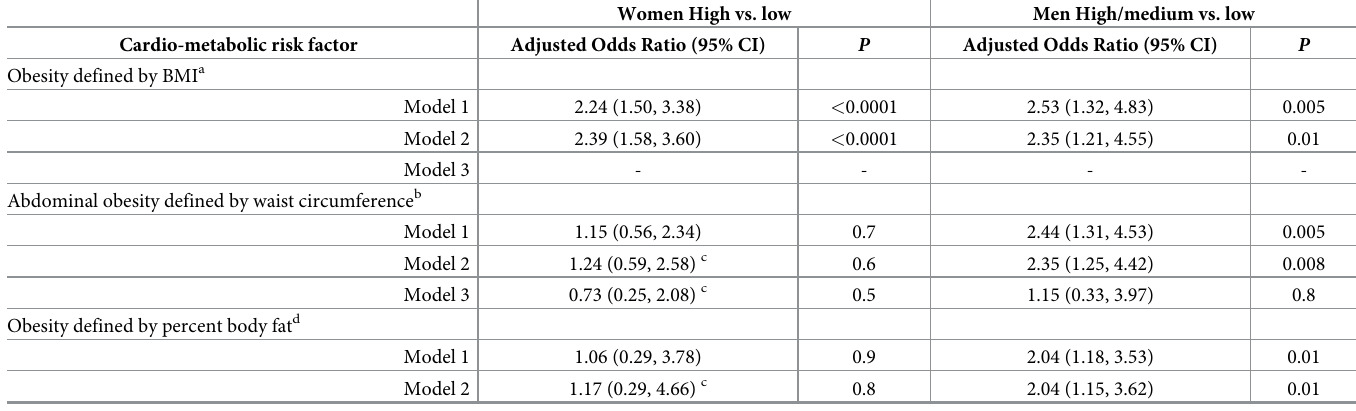
Table 2. Multivariable logistic regression models to predict cardio-metabolic disease risk factors in 2015–17 after 40 years of follow up at age 37–54 years based on body mass index latent class trajectory from infancy through mid-adulthood (high vs. low in women and high/medium vs. low in men) in the INCAP nutrition sup- plementation trial longitudinal cohort (n = 510 women, n = 346